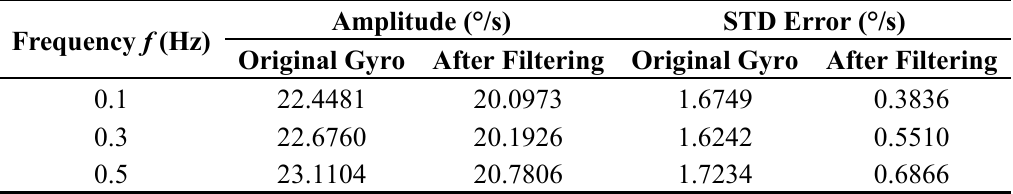
Figure 8. Swing rate test results of KF for frequency f = 0.1, 0.3 and 0.5 Hz. Table 4. Swing test results of gyroscope before and after KF